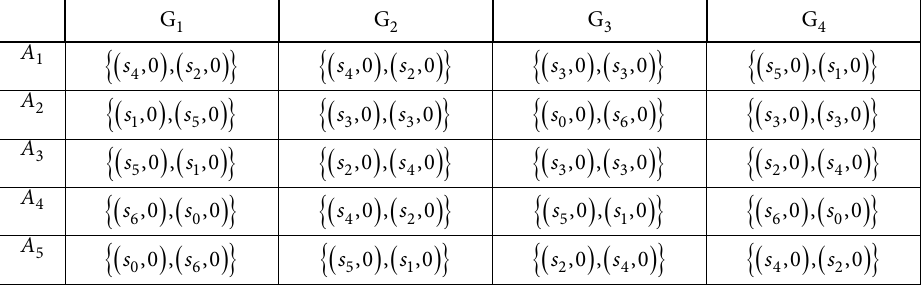
Table 6. The assessing matrix with 2TLPFNs by second expert